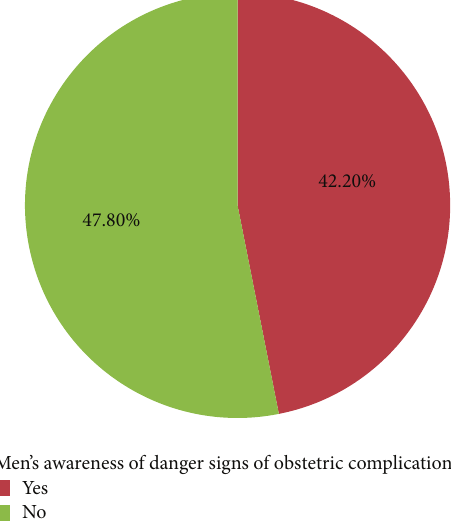
associated with men awareness of danger signs of obstetric